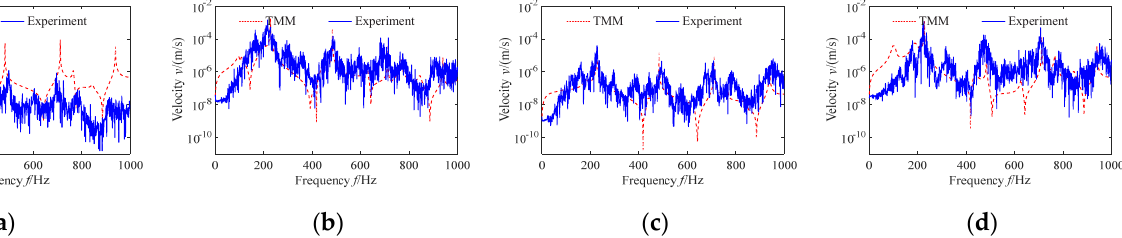
Figure 15. Velocity responses of pipe (case 3). ( a ) Axial velocity of point A. ( b ) Radial velocity of point A. ( c ) Axial velocity of point B. ( d ) Radial velocity of point B. Table 11. Resonant frequencies of pipe (case 3).